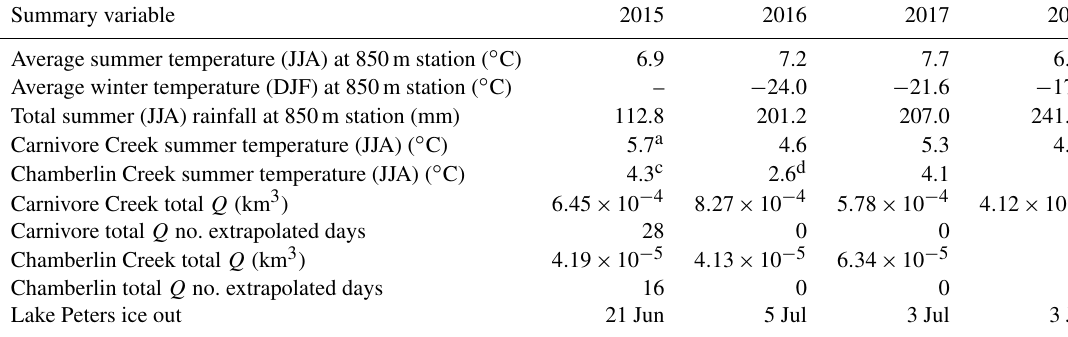
Figure 1. Temporal coverage of data collected in the Lake Peters catchment. Data are either continuous hourly or bi-hourly observations (bars) or discrete observations in time (dots). Data are indicated as available if any variable is present for the given time. Observations and samples from sediment traps are not hourly but were collected over specific windows of time. The 1 January of each year is marked with a dotted line. Data collected from different parts of the Lake Peters catchment are shown with different colors in roughly the same order as they are discussed in Sect. 3. See Sect. 3 for a more detailed description of the data. Some data (Lake Peters TROLL casts and bathymetry) are not represented in this figure. Table 1. Summary of key meteorological and hydrological variables observed in the Lake Peters watershed. DJF temperatures include December of the previous year. The number of extrapolated days for full-season discharge ( Q ) measurements refers to the number of late- season days for which flow occurred but was not measured by our instruments, and was therefore extrapolated using methods described in Sect.